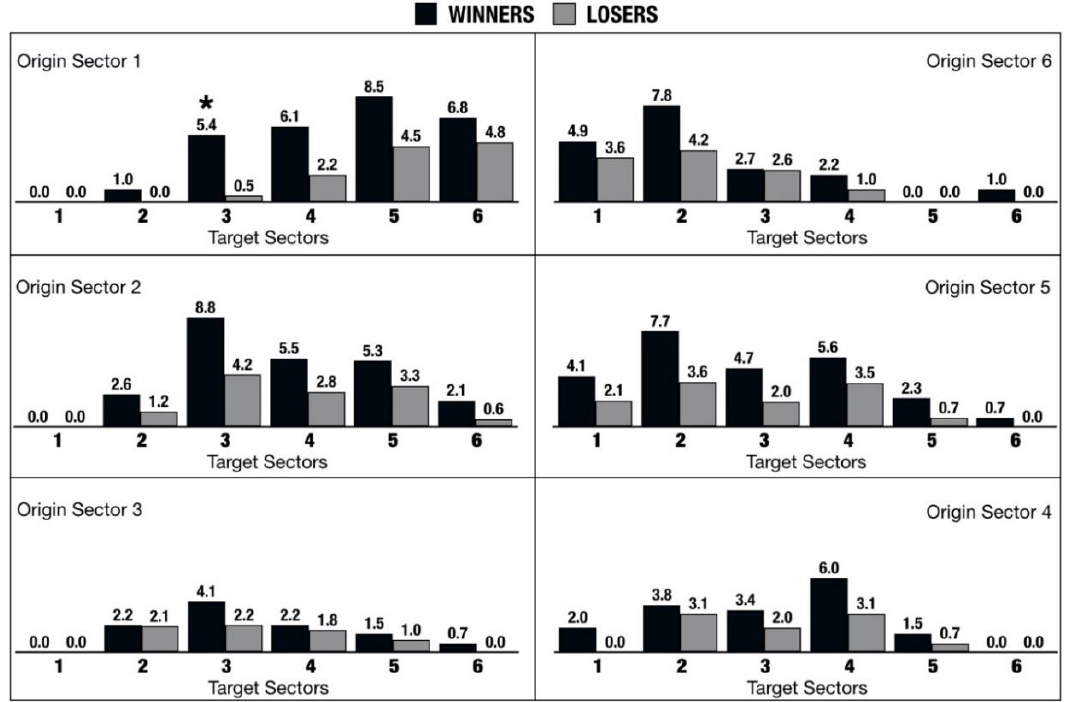
Figure 3. Comparison of mean attack efficacy for winners vs. losers. * p < .05; ** p < .01 *** p<.001. Note: in some cases, not exactly 100% due to rounding.